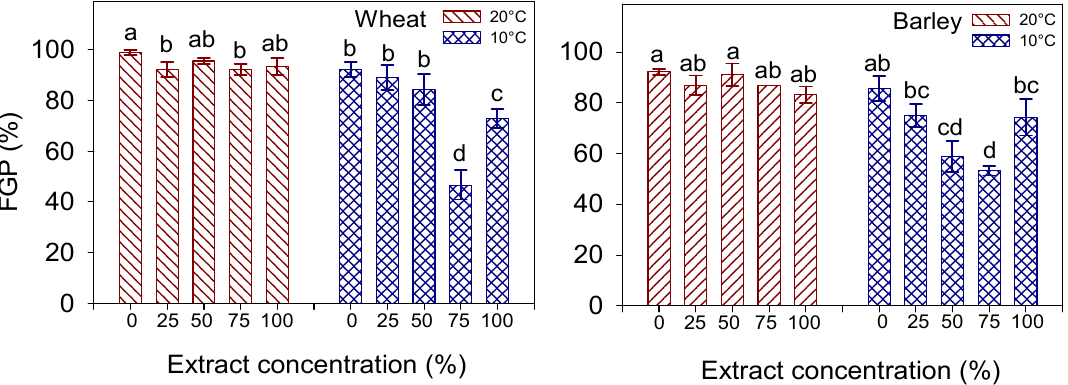
Figure 2. Interaction effect of ‘temperature × extract concentration’ on final seed germination percentage (FGP, %) in wheat cv. Mongibello and barley cv. Alamo. Data are means ± se ( n = 4). Different letters indicate significance at p < 0.05 according to Tukey’ test.